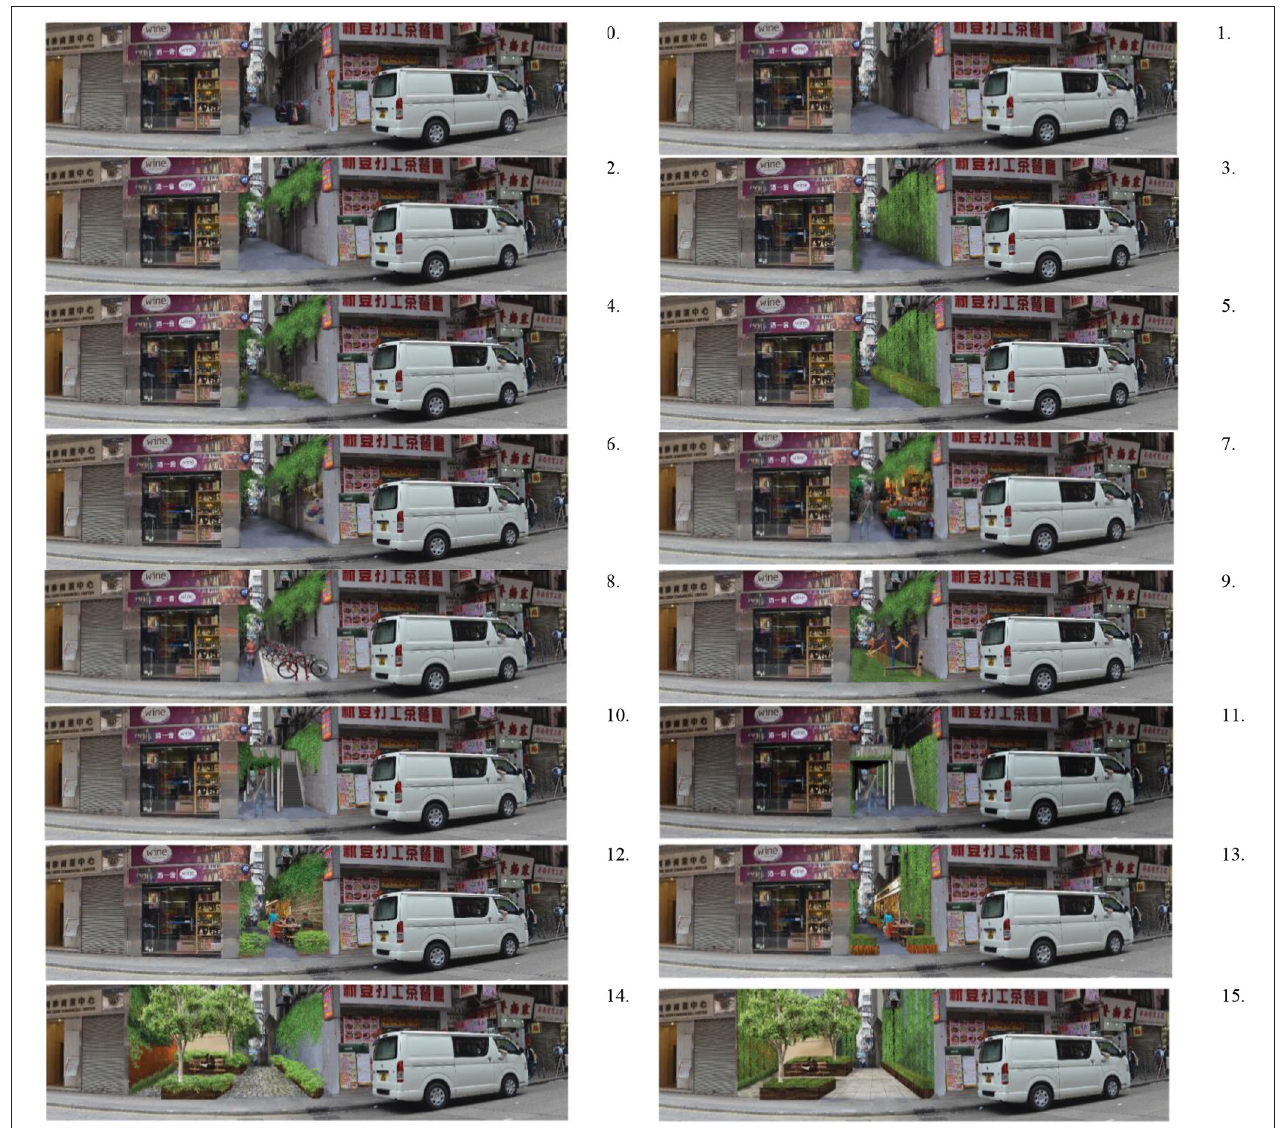
FIGURE 4 | The baseline image and 15 simulated images for one site. 0, baseline; 1, cleaning; 2, naturalistic green wall; 3, geometric green wall; 4, naturalistic green wall & ground; 5, geometric green wall & ground; 6, green art gallery; 7, green shop; 8, green cycling; 9, green gym; 10, naturalistic green platform; 11, geometric green platform; 12, naturalistic green café; 13, geometric green café; 14, naturalistic green park; 15, geometric green